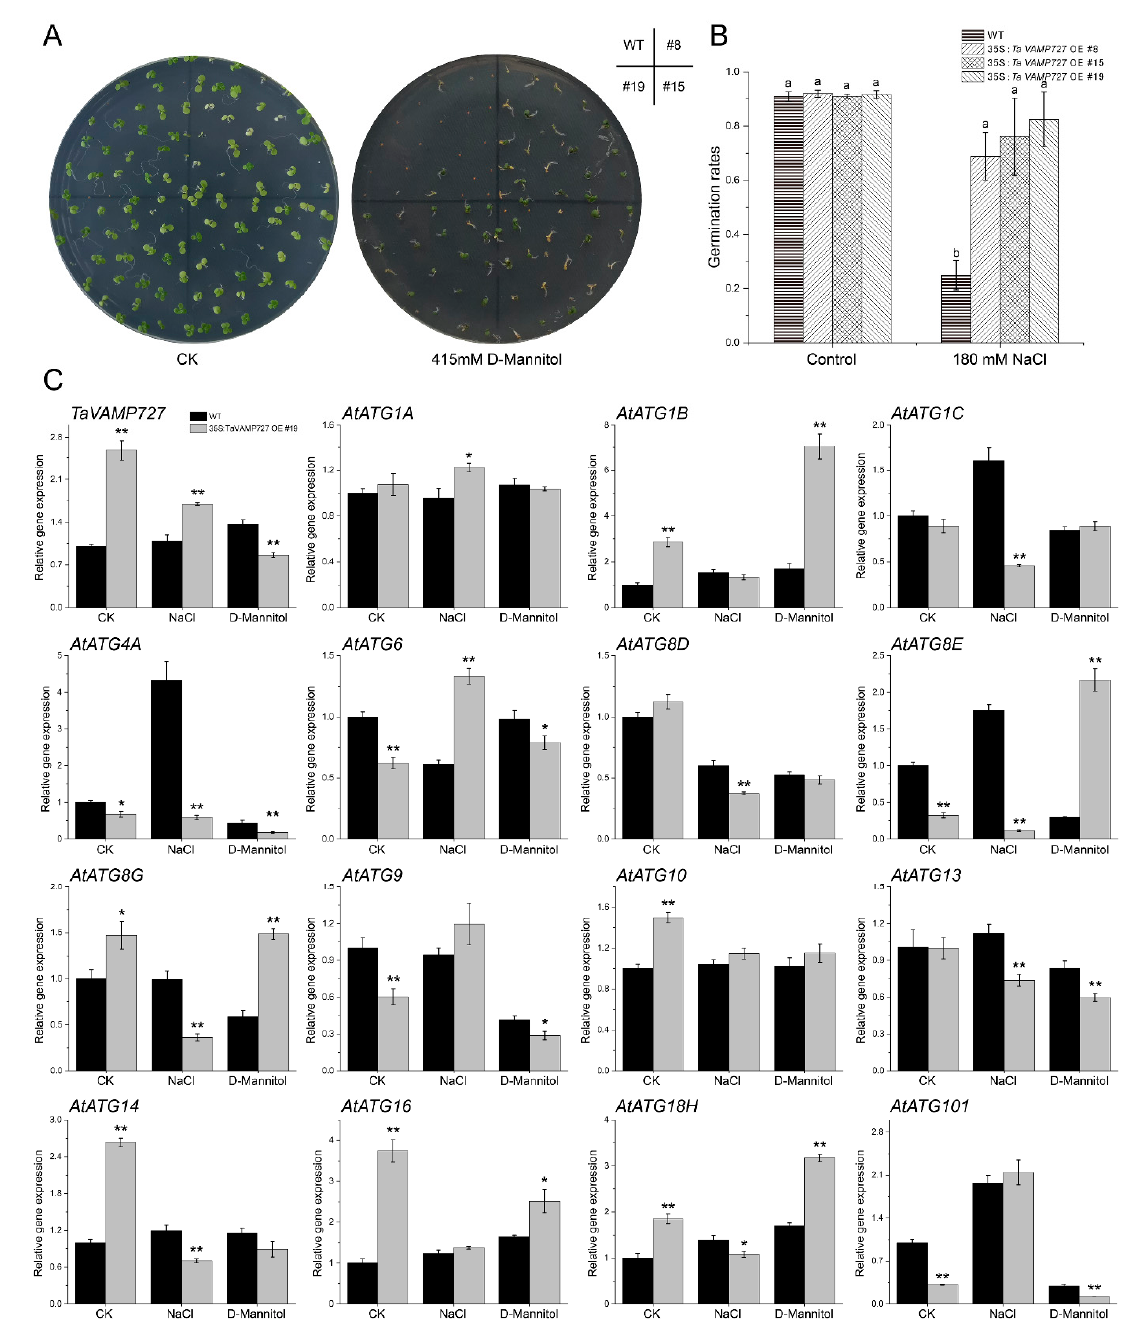
Figure 7. Influence of TaVAMP727 on ATGs in Arabidopsis . ( A , B ) The germination rate of TaVAMP727 overexpressed lines under either drought (415 mM D-mannitol) or salt (180 mM NaCl) stress. Error bars represent the SD. Columns bars followed by different letters are statistically different according to the analysis of variance followed by Duncan’s Multiple Range Test (control, p = 0.84; 180 mM NaCl, p = 0.0018; n = 3). ( C ) The expression levels of overexpressed TaVAMP727 and 15 Arabidopsis ATGs were analyzed via reverse transcription-quantitative real-time PCR (RT-qPCR) in both wild-type and TaVAMP727 transgenic line #19 under salt and drought stress. The ubiquitin 5 ( UBQ5 ) ( At3G62250 ) was used as housekeeping genes. Error bars represent the SD. * p < 0.05; ** p < 0.01; n =